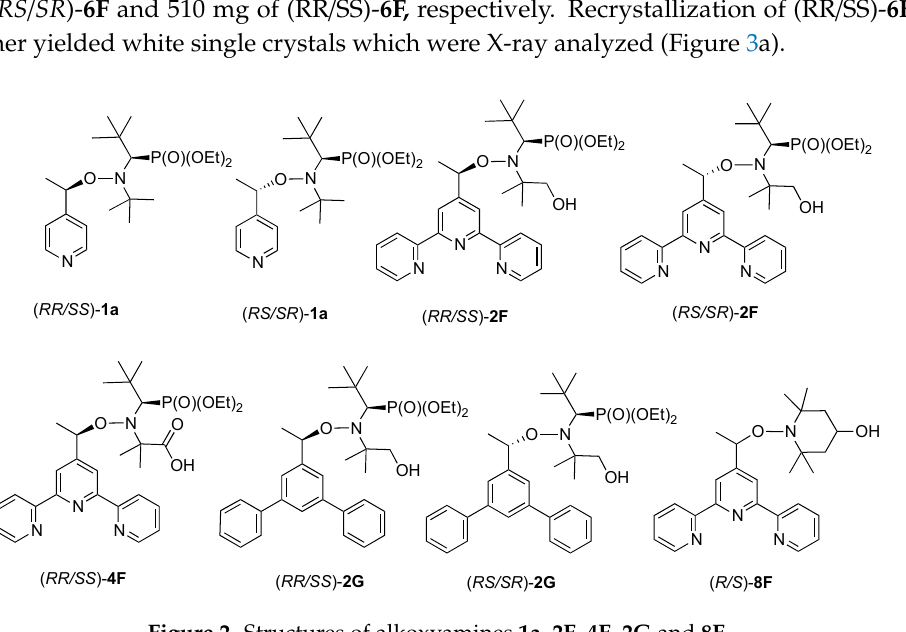
Figure 2. Structures of alkoxyamines 1a , 2F , 4F , 2G and 8F .